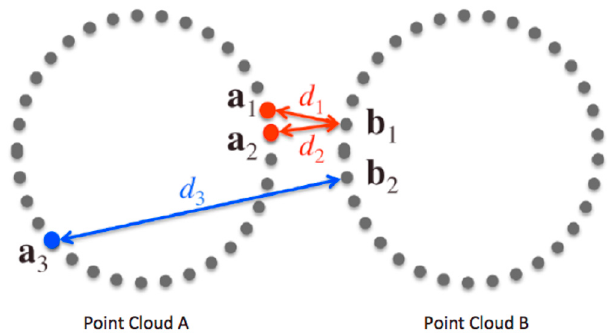
Figure 3. Inter-point distance between point a i in point cloud A and its nearest neighboring point b j in point cloud B.